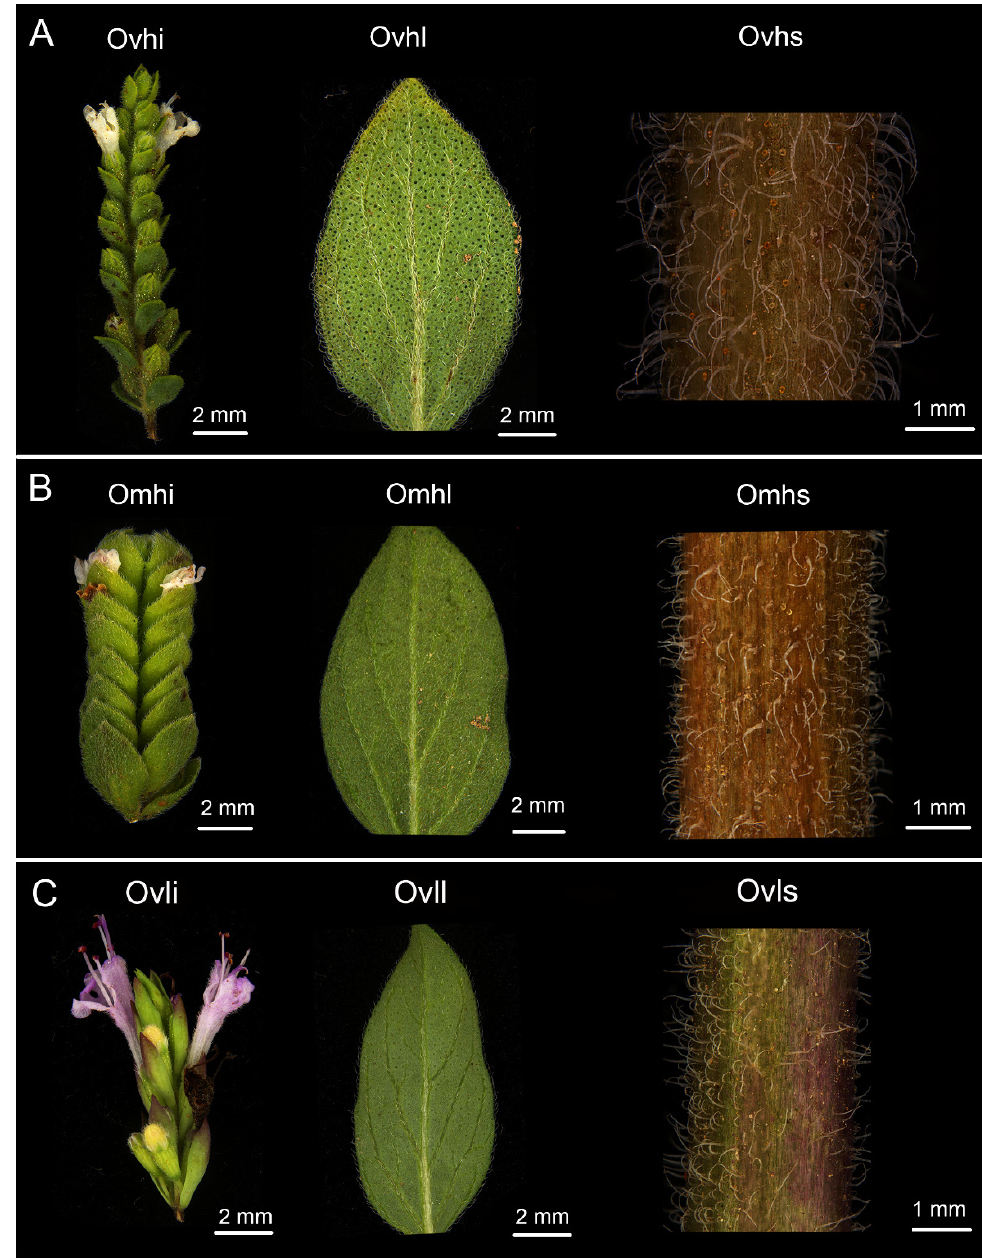
Figure 1. Inflorescences, leaves, and stems of three oregano plants (( A ) Ovh; ( B ) Omh; ( C ) Ovl). Interestingly, in this study, we observed differences in the density of glandular tri- chomes on the leaves of the three oregano plants (Figure 1). Overall, the density of glandular trichomes decreased in the following order: Ovhl > Omhl > Ovll. The number of glandular trichomes on the leaves of aromatic plants was linearly associated with their EO yields. As a result, the greater the number of glandular trichomes on the leaves, the higher the amount of EOs derived from the leaves by distillation [15]. Importantly, the density of glandular trichomes on the leaf surface is functionally associated with transpiration, leaf overheating, insect attack, and UV-B radiation, among other factors. The shape, density, size, and position of the glandular trichomes, as well as the oily properties, chemical constitutions, and fragrance characteristics of the EOs are carefully controlled parameters in aromatic plants, and further studies are needed to improve our understanding of the structural, functional, and ecological features of glandular trichomes and their